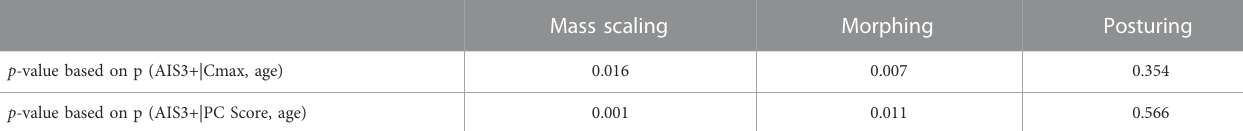
TABLE 7 Summary of the p -value of the p (AIS3+) discretized by personalization technique and injury metric ( α = 0.05). Mass scaling Morphing